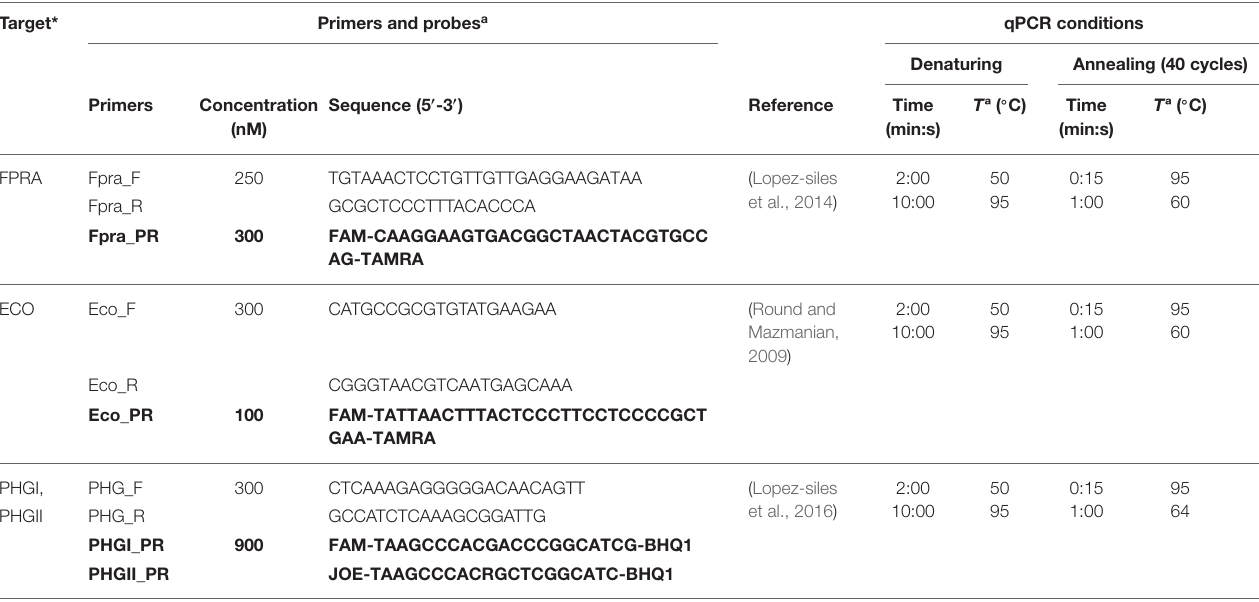
TABLE 1 | 16S rRNA-targeted primers and probes sequences, concentrations, and qPCR conditions used for IBD-associated bacterial markers in this work for TaqMan